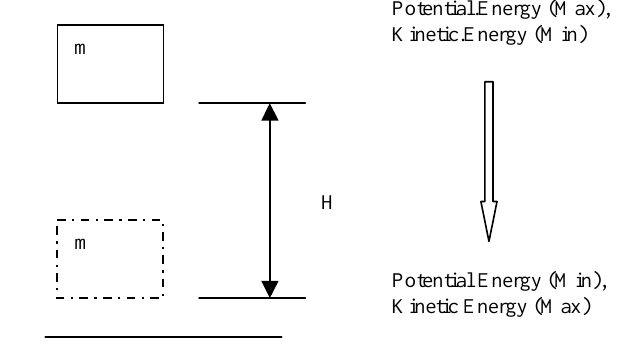
Fig. 1. Schematic diagram of free drop.